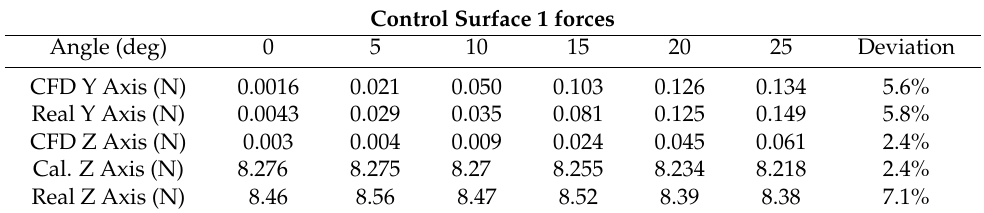
Table 3. Forces generated by Control Surface 1 at various deflection angles.